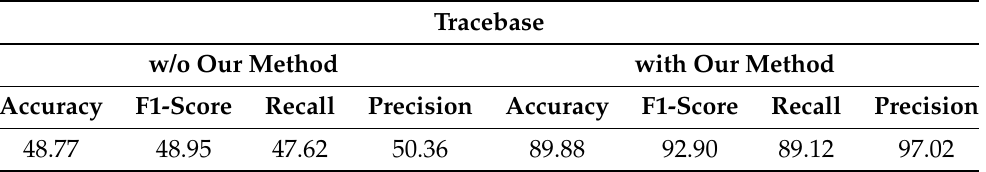
Table 12. The results of combinations of five appliances with Xception